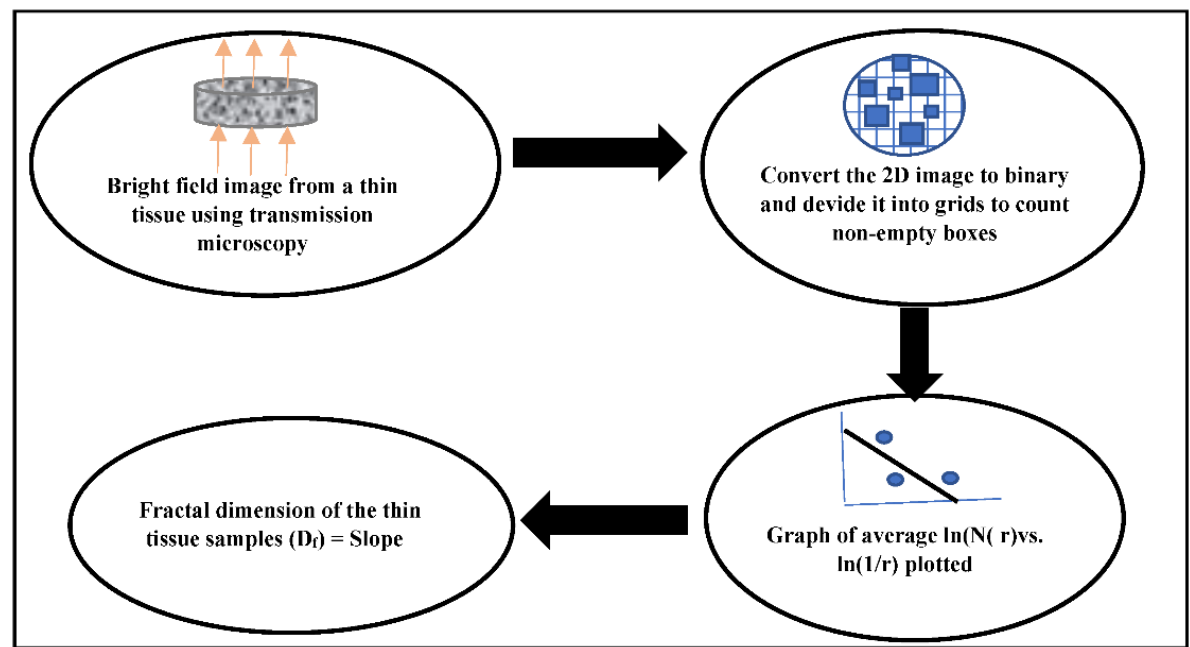
Figure 1. The step-by-step process for calculating the fractal dimension of a microscopic image is outlined.